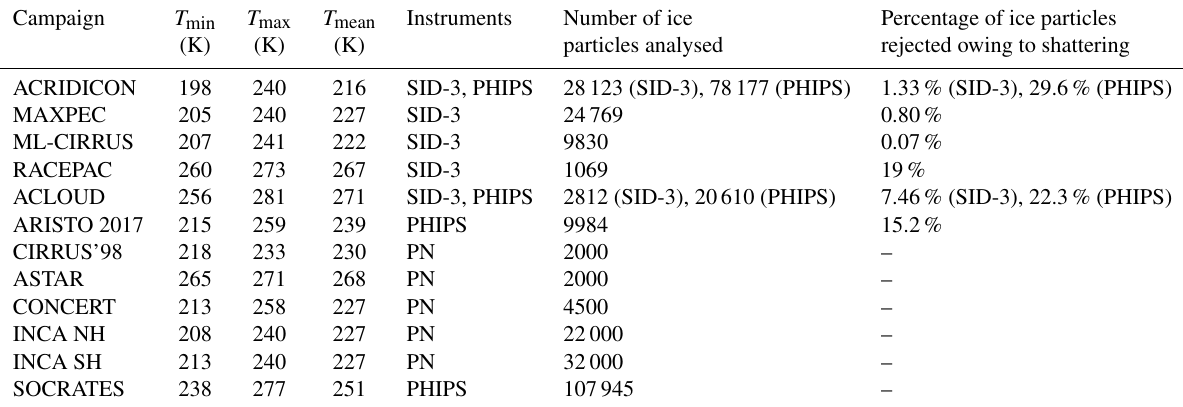
Table 2. Overview of the measurement campaigns. Temperature range (minimum, maximum and mean) during measurements in ice con- taining clouds, the operated instrumentation, the number of ice particles included in the analysis and the percentage of ice particles rejected from the analysis owing to shattering. No particles were rejected from the SOCRATES data set since only PHIPS data sets with manually classified images were